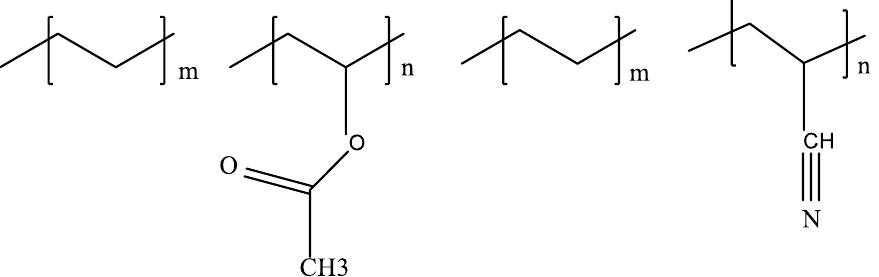
Figure 3. Ethylene/vinyl acetate (left) and ethylene/acrylonitrile copolymers (right) [38]. Comb-Shaped